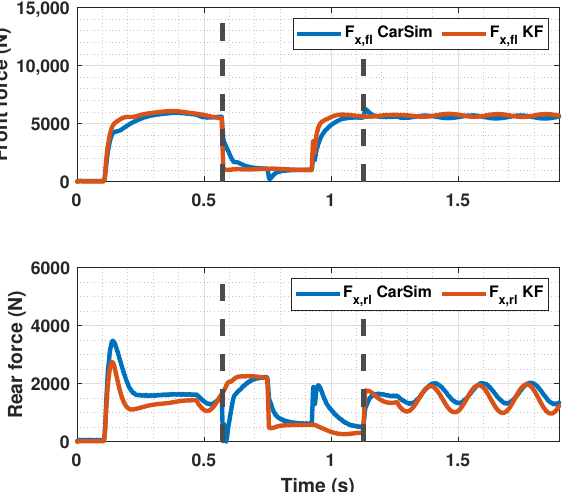
Figure 16. Estimated forces by KF compared with CarSim forces for changing µ max